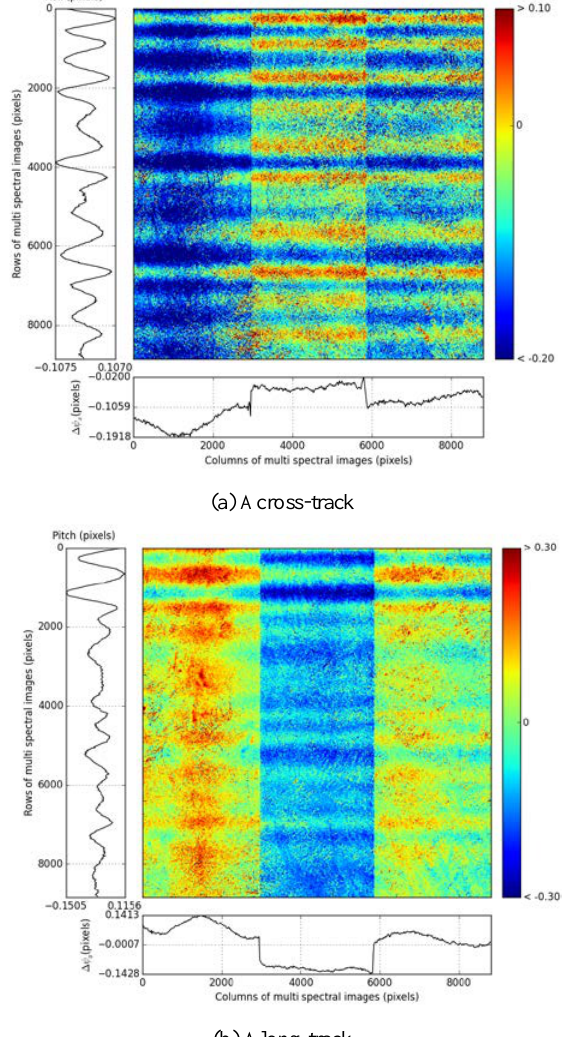
Figure 3 Band-to-band misregistration of Dengfeng dataset with third-order polynomials. Figure 4 Band-to-band misregistration of Faizabad dataset with cubic